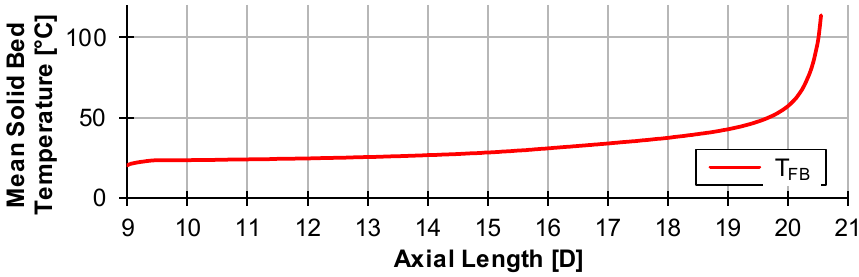
Figure 16. Mean Temperature of solid bed of an D = 60 mm extruder with a three-section-screw.